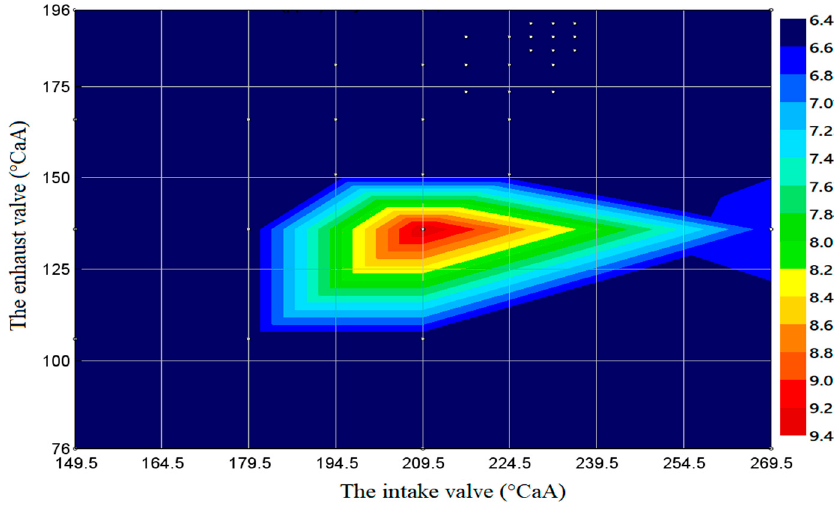
Figure 18. 100% load condition.